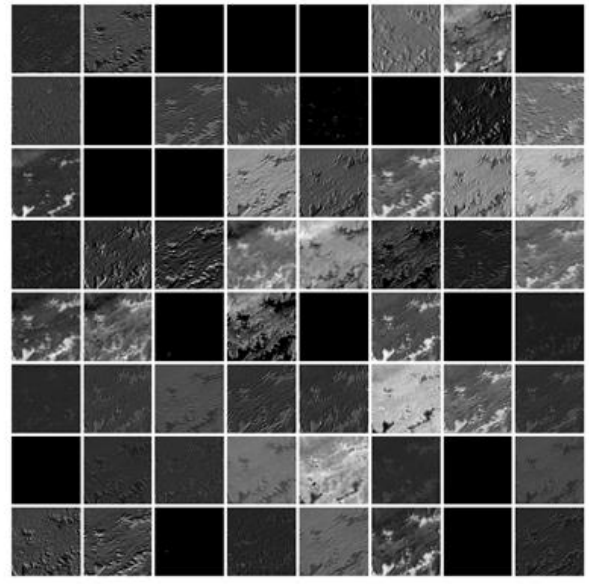
Figure 5. Feature map after ReLU activation function.